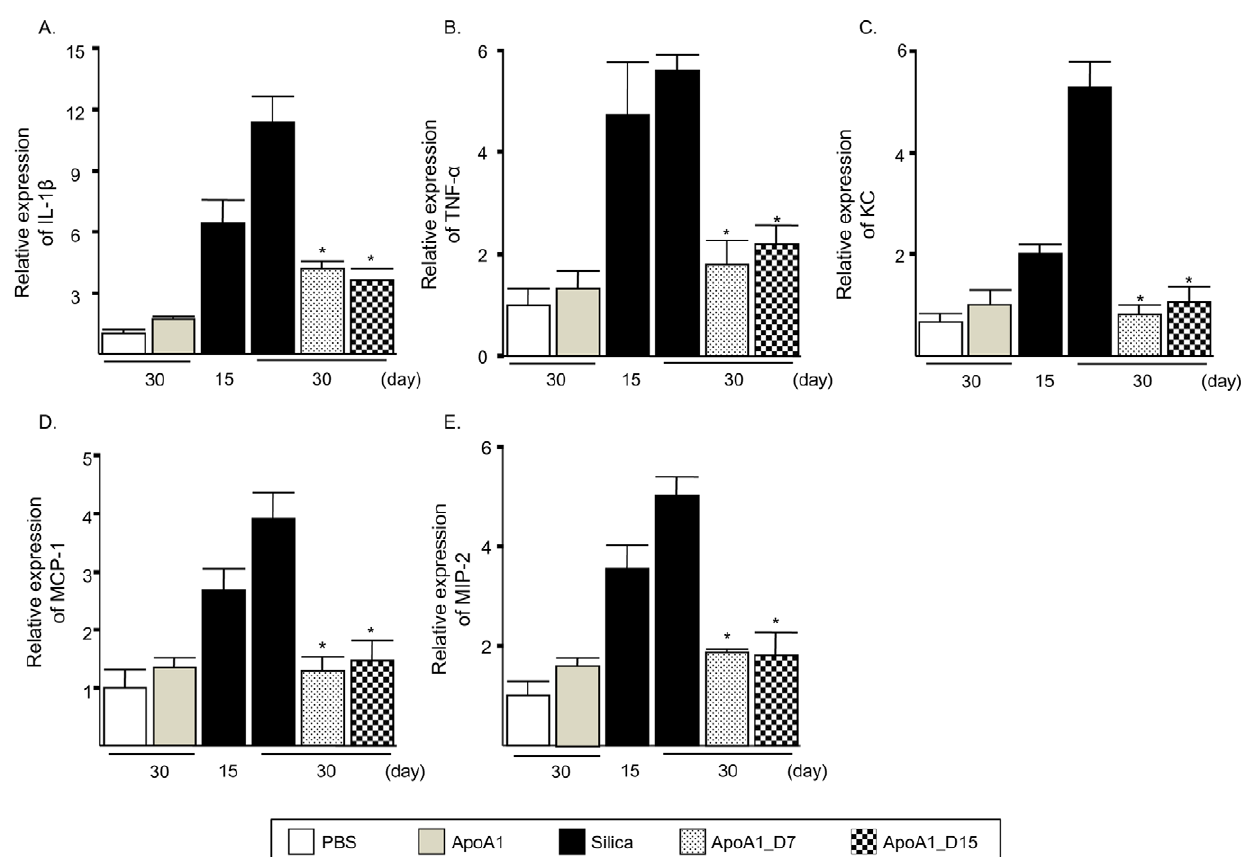
Figure 7. Levels of proinflammatory mediator mRNAs in the lungs of ApoA1 transgenic mice. IL-1 b (A) , TNF- a (B) , KC (C) , MCP-1 (D) and MIP-2 (E) mRNA expression were measured by real-time PCR. * p , 0.05 compared with the Silica group (D30).